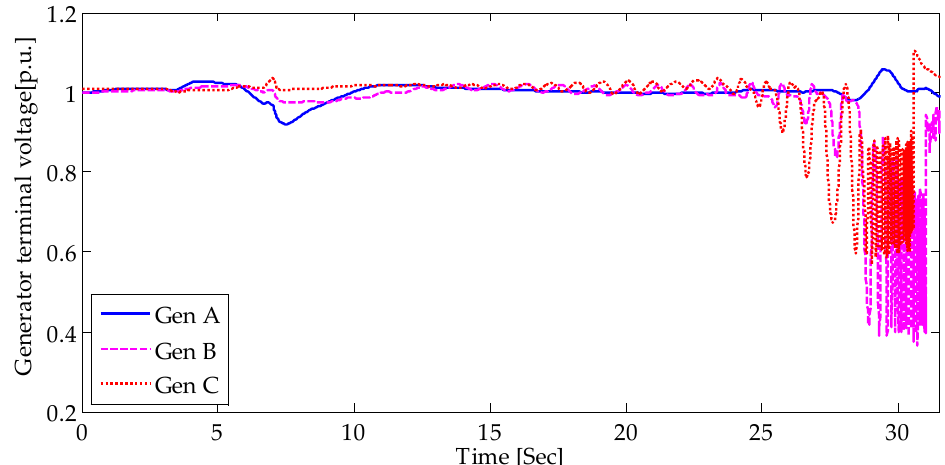
Figure 10. Generator terminal voltage magnitude with the target location of Gangneung.